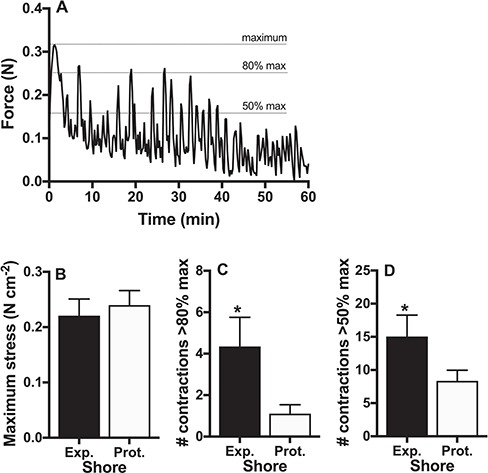
Mechanics of isolated muscle. An typical experimental trace (A) shows maximum force production, and 80% and 50% of maximum, which we used to evaluate endurance. Maximum stress (B) did not differ between snails from exposed (Exp., black bars) and protected shores (Prot., white bars), but snails from exposed shores showed greater fatigue resistance and produced more contractions above 80% of maximum (C) and above 50% of maximum (D) over time, compared to snails from protected shores. Means ± s.e. are shown and n = 20 snails per shore from a single site; asterisks indicate significant differences between shores.